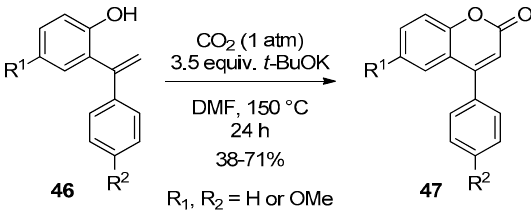
Scheme 9. Synthesis of 4-arylcoumarins via transition-metal-free cyclocarboxylation.